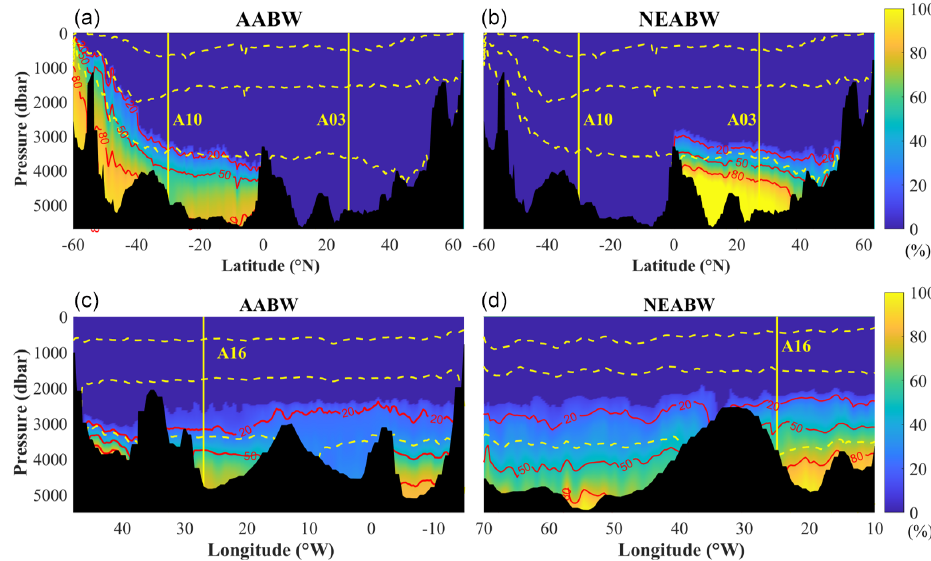
Figure 16. Distribution of AABW and NEABW based on A16 (a, b) , A10 (c) and A03 (d) sections. Contour lines show fractions of 20%, 50% and 80%, yellow vertical lines show cross overs with other sections, and dashed yellow lines show the boundaries of vertical water columns layers (neutral density at 27.10, 27.90 and 28.10kgm − 3 ).